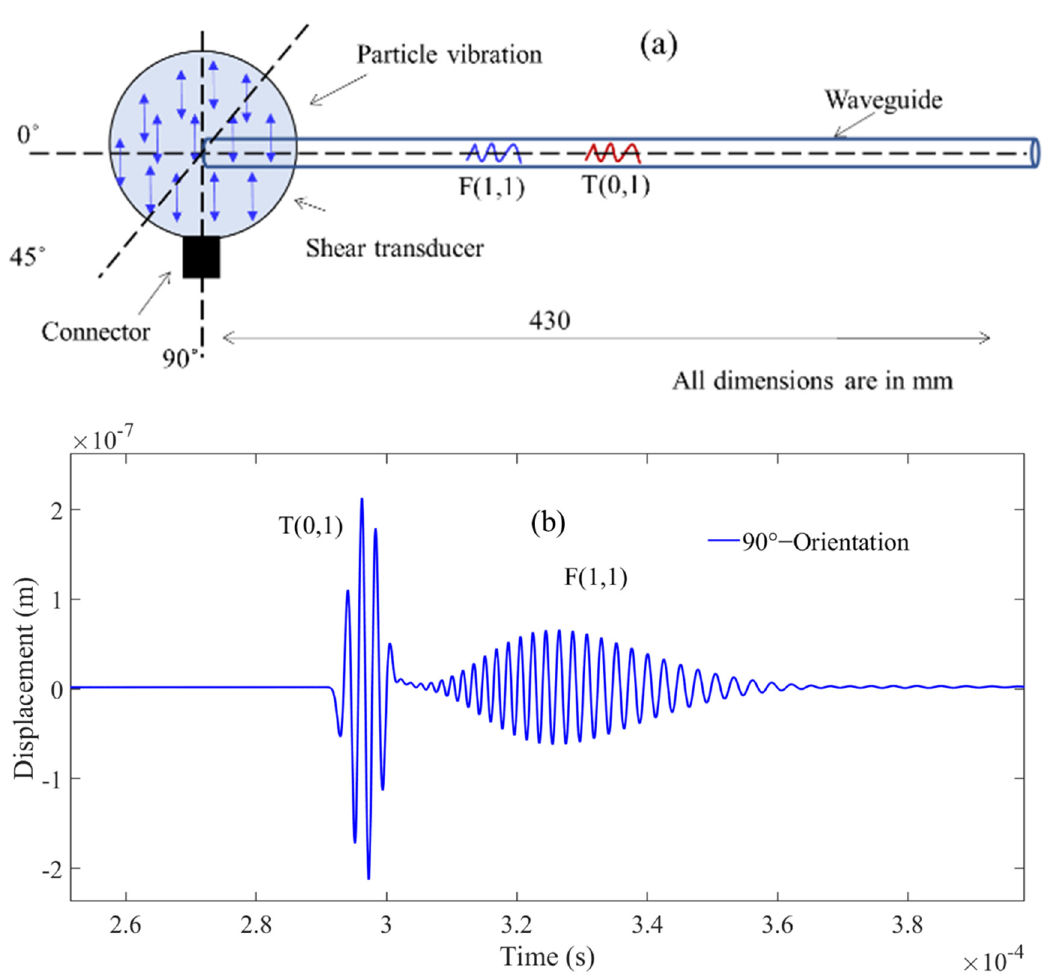
Figure 4. ( a ) Shows the shear transducer orientation (90°) to the waveguide axis ( b ) and the reflected A-Scan signals with T(0,1), and F(1,1).